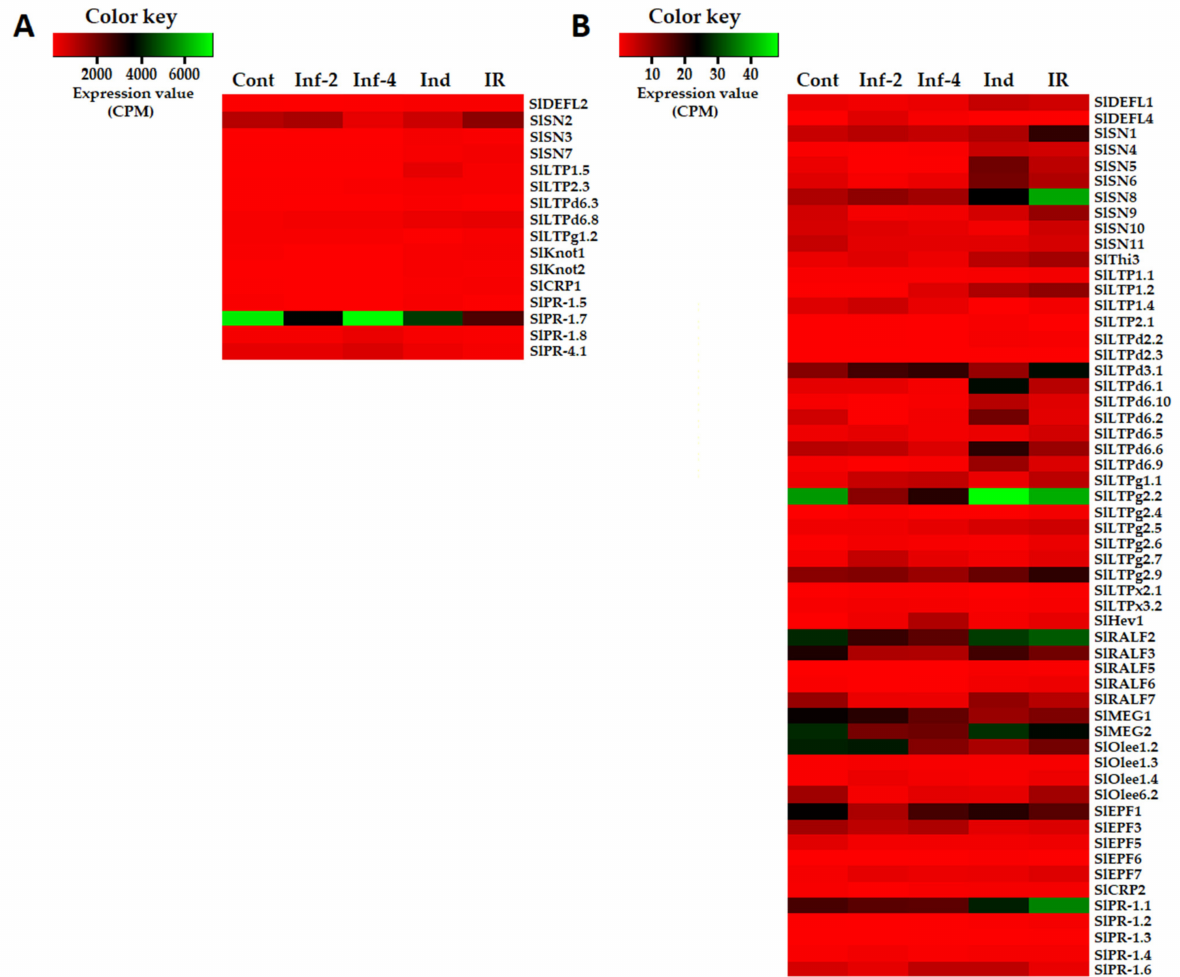
Figure 2. Heatmaps of differentially expressed CRP genes. ( A ) Genes with expression levels above 50 CPM (Counts per Million Mapped Reads) at least in one transcriptome. ( B ) Genes with expression levels below 50 CPM in all transcriptomes. Cont, Inf-2, Inf-4, Ind, and IR designate control, infected at 2 or 4 dpi, induced and IR-displaying plants,